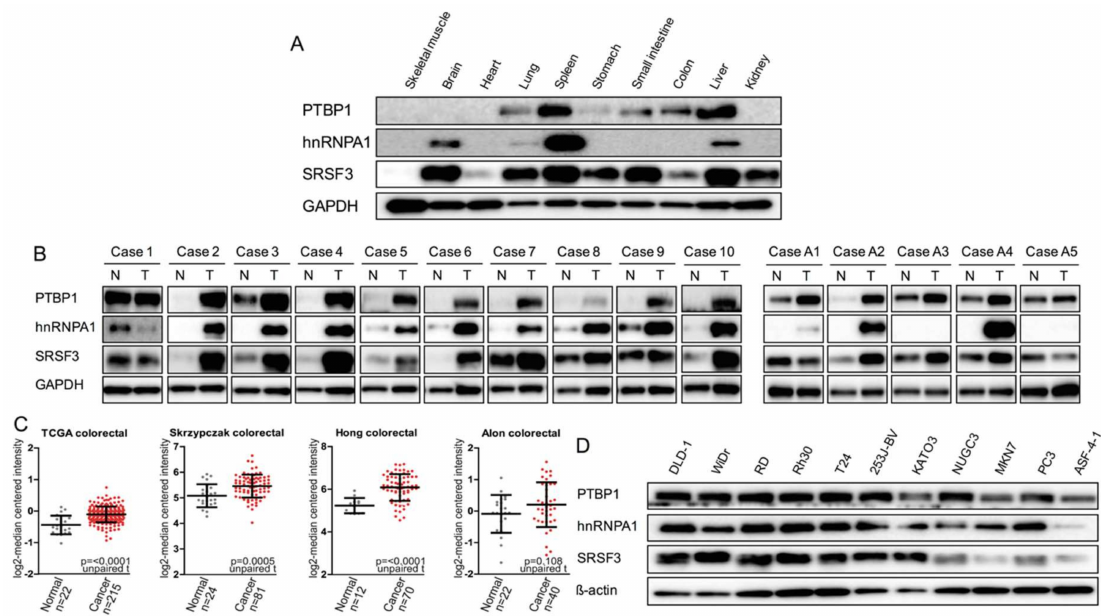
Figure 1. Expression profiles of polypyrimidine tract binding protein 1 (PTBP1), heterogeneous nuclear ribonucleoprotein A1 (hnRNPA1), and serine and arginine rich splicing factor 3 (SRSF3) in mouse normal tissues and colon tumor samples from the patients. ( A ) Western blot of PTBP1, hnRNPA1, and SRSF3 in normal mouse organs. PTBP1, hnRNPA1, SRSF3, and glyceraldehyde-3-phosphate dehydrogenase (GAPDH) were detected in the same membrane; ( B ) Western blot of three proteins in colon tumor samples from the patients. N: normal, T: tumor tissue. Cases 1–10 are cancer samples; and A1–A5, adenoma samples. PTBP1, hnRNPA1, SRSF3, and GAPDH were detected in the same membrane; ( C ) The SFRS3 mRNA expression level was examined for the indicated colorectal cancer cohorts. The unpaired T test was carried out to assess difference between the expression of SFRS3 mRNA in normal and cancer tissues. Error bar indicates standard deviation; ( D ) Western blot of these three proteins in the indicated cancer cell lines and in ASF-4-1 (human fibroblast) cells. PTBP1, hnRNPA1, SRSF3, and GAPDH were detected in the same